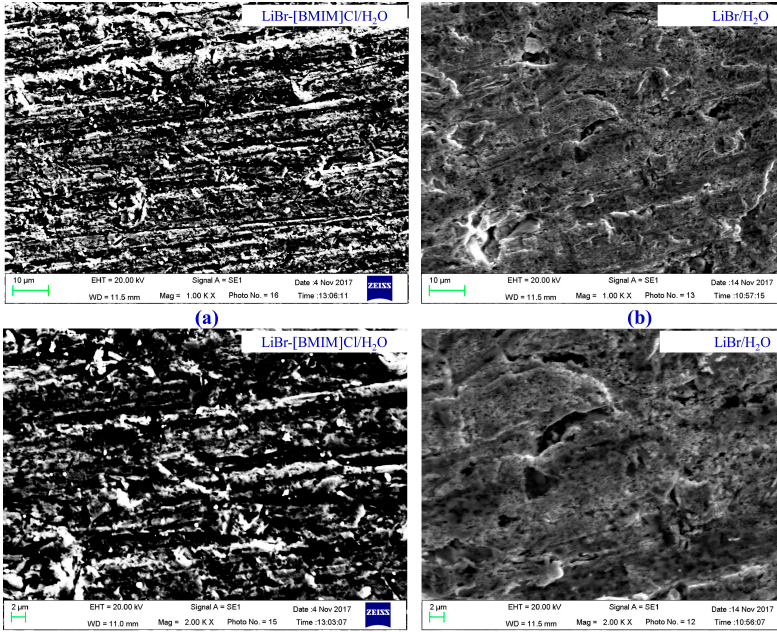
Figure 4. SEM micrograph of copper surface in LiBr–[BMIM]Cl/H 2 O and LiBr/H 2 O with w = 0.004 Na 2 SiO 3 and w = 0.001 polyaspartate.